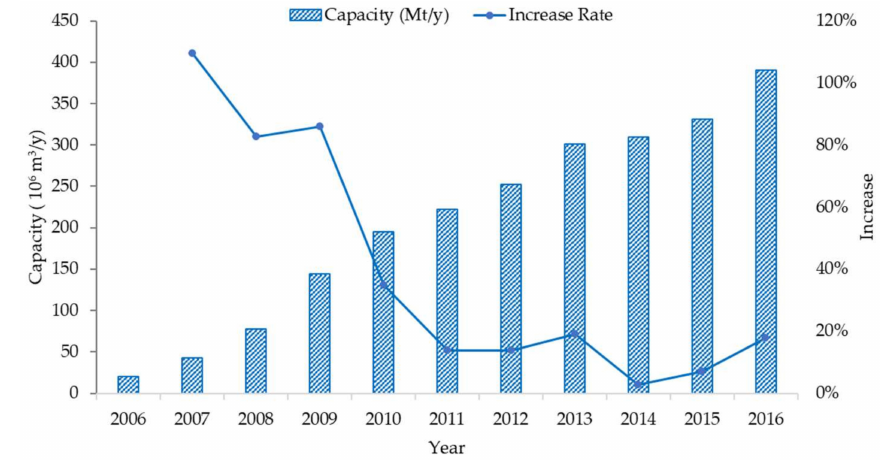
Figure 3. Total seawater desalination plant capacities in China from 2006 to 2016 (Based on [14]).